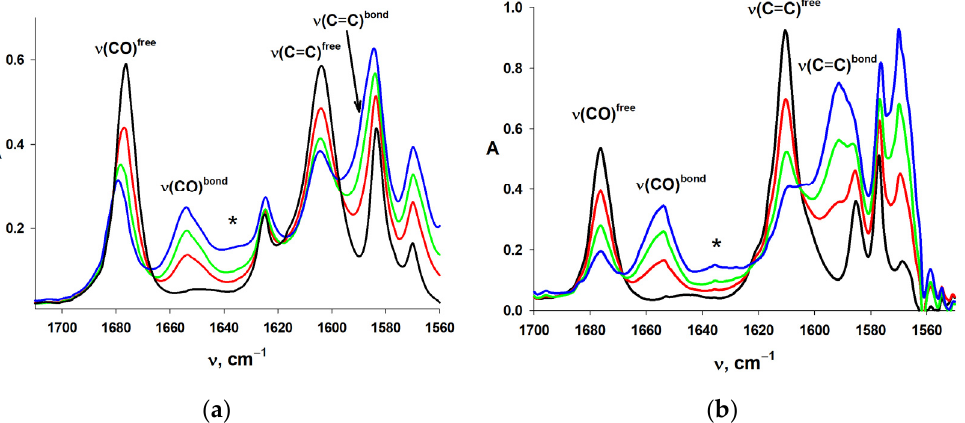
Figure 1. The IR spectra of E- 1 ( a ) and E- 2 ( b ), (c = 0.015, d = 1 mm, black line), in the presence of 0.5 (red), 1 (green), and 2 (blue) equivalents of [AgPz] 3 ; CCl 4 , 298 K. * δ (C-N) [AgPz]3. E- 1 and E- 2 have one, relatively easy-to-isomerize, double bond. These compounds also possess two single C-C(O) bonds allowing the formation of the eight isomers/rotamers (Scheme 2; also see Scheme S1 in SI).